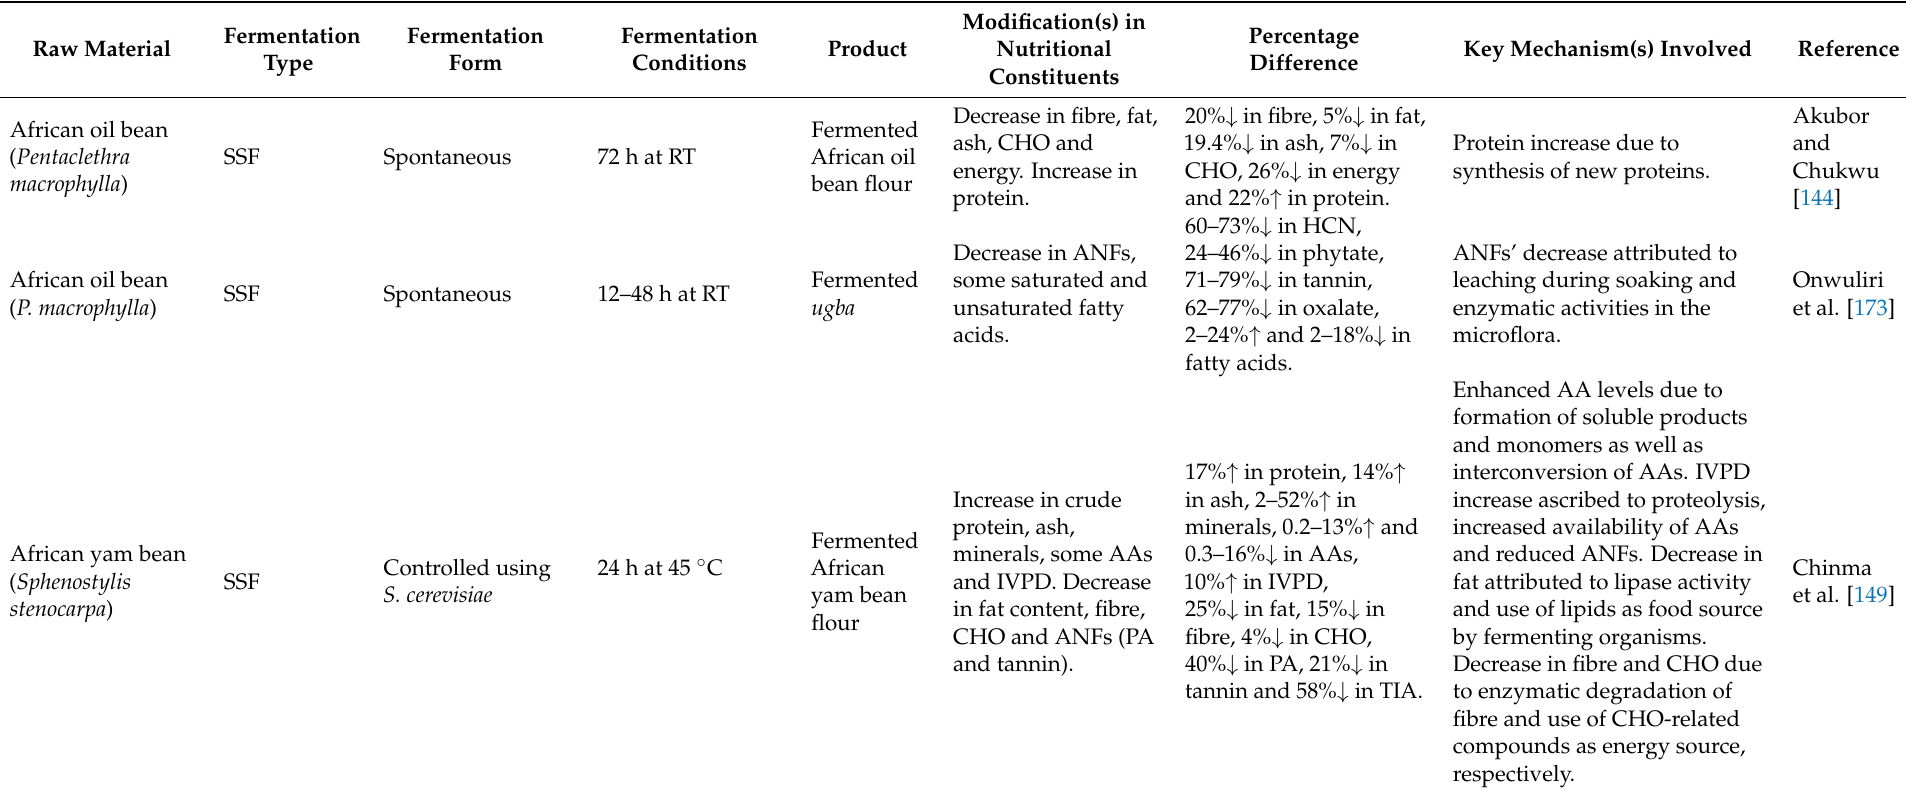
Table 4. Influence of fermentation on the nutritional composition of some legume-based